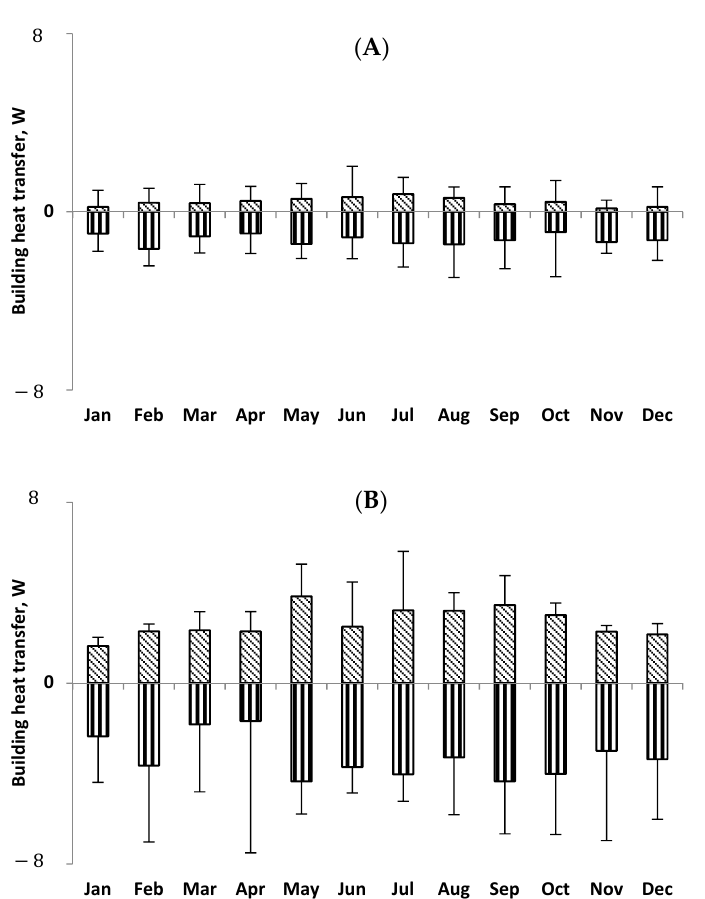
Figure 7. Building heat transfer of the underground room ( A ) and above ground room ( B ).